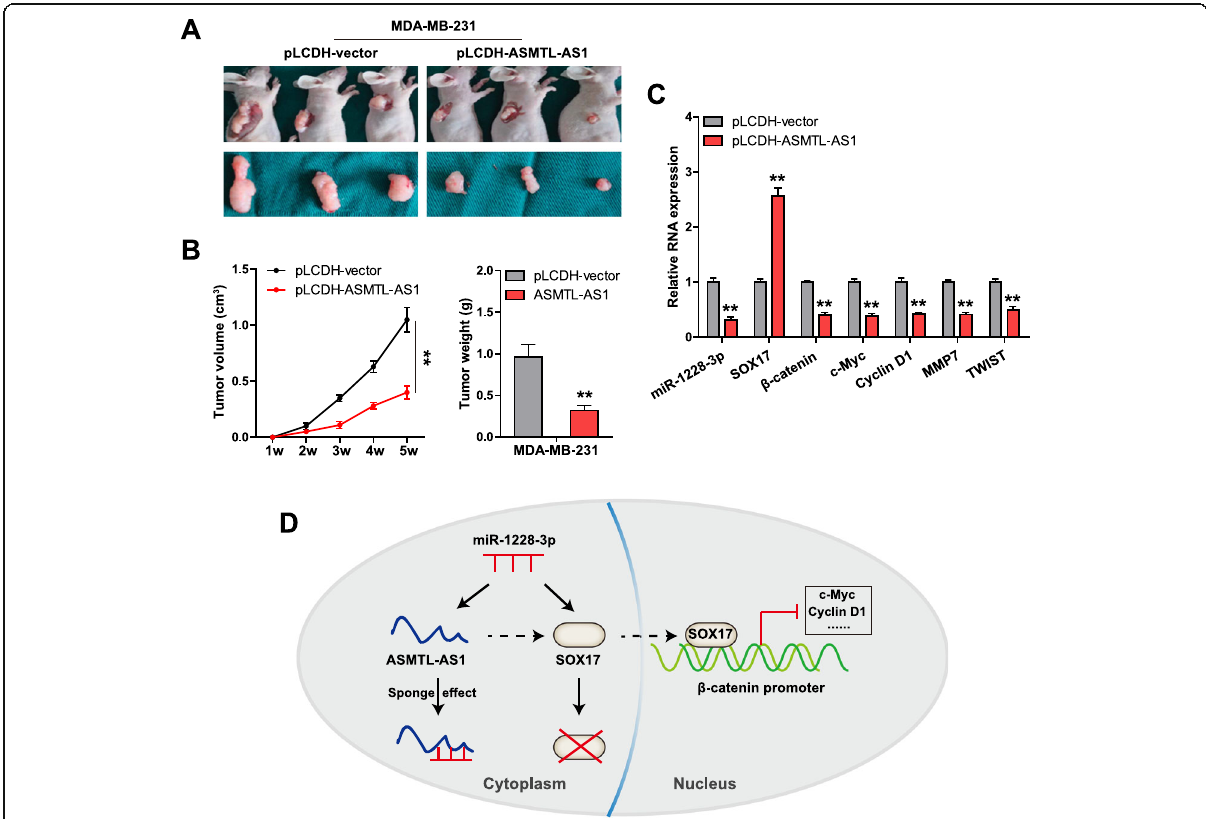
Fig. 5 Recovery of ASMTL-AS1 inhibits tumor growth. a , b . Tumor volume and weight in control and ASMTL-AS1-overexpressing groups. c . qRT- PCR analysis of the indicated gene levels in control and ASMTL-AS1-overexpressing tumors. d . The mechanism diagram showing that ASMTL-AS1 inhibits TNBC progression via the miR-1228-3p/SOX17/Wnt/ β -catenin